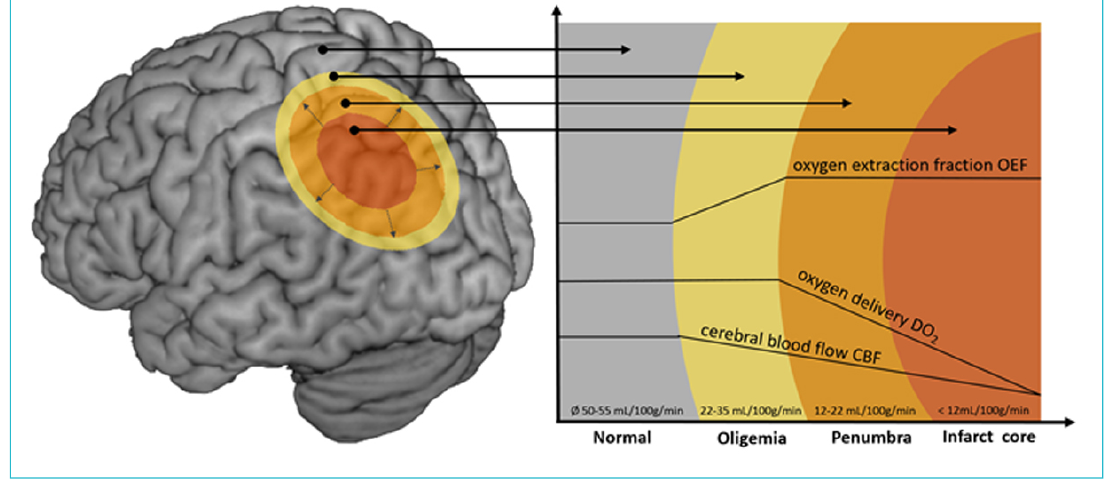
Figure 3: Illustration of the penumbra concept. Infarct core (red): infarcted tissue. Penumbra (orange): salvageable tissue at risk for infarction in case of persistence vessel occlusion. Oligaemia (yellow): hypoperfused tissue without risk for infarction. Cerebral blood flow decreases in direction to the infarct core. Decreased blood flow can be compensated by an increased oxygen extraction fraction and vasodilation of collater- al vessels sufficiently enough in the oligaemia but not in the penumbra. (Picture: Stroke Centre Bern)